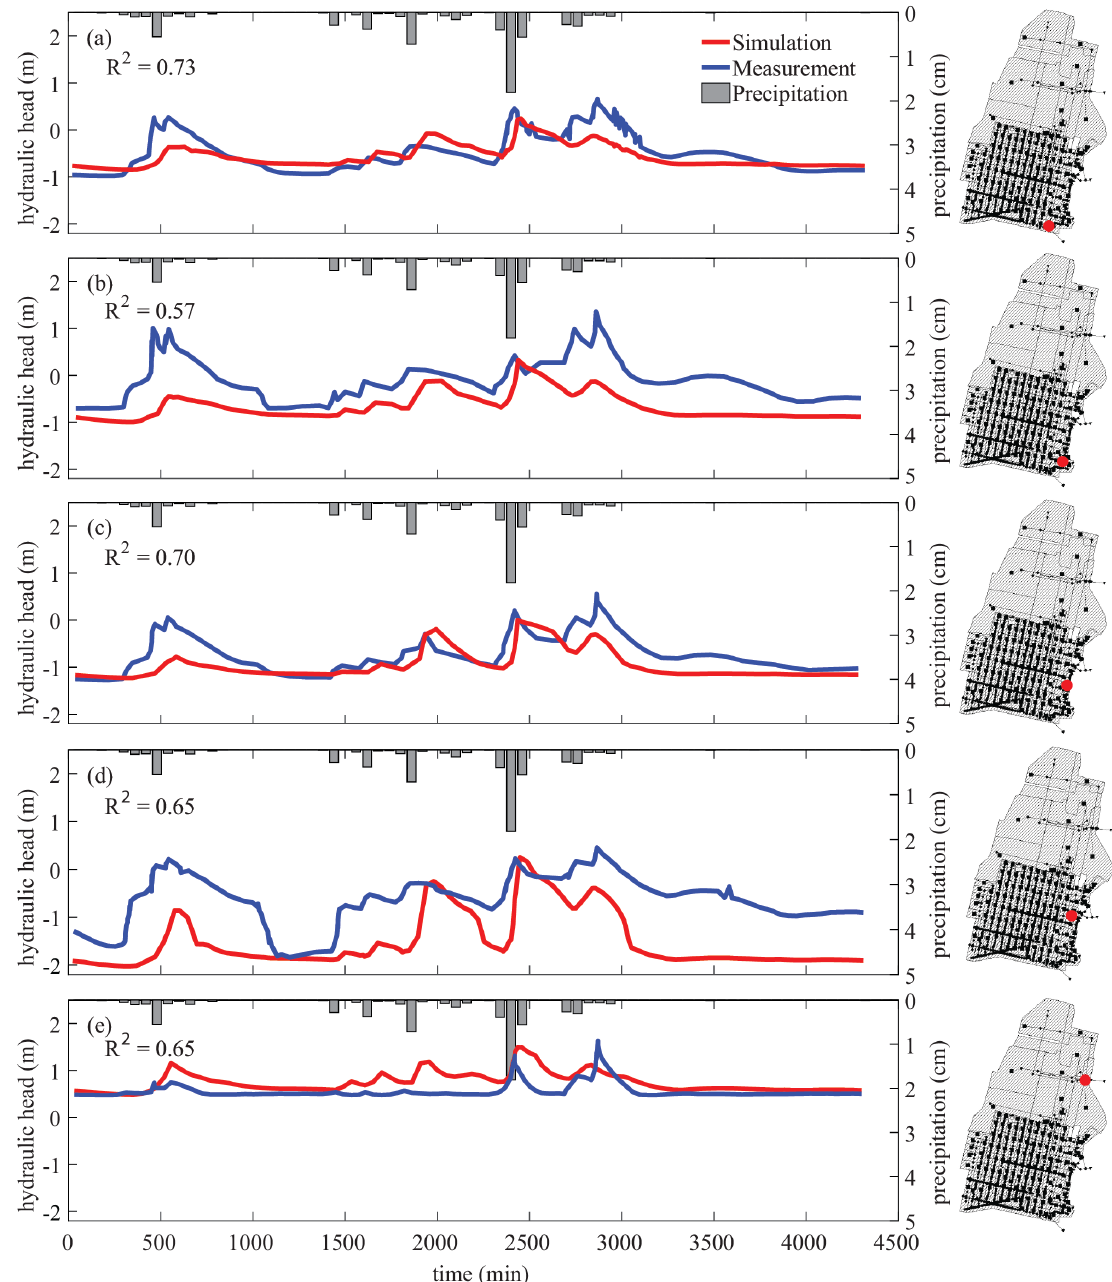
Figure 6. Validation of the sewer model in WWCs. The diagrams report the hydraulic head of the water within the pipe (solid lines) and precipitation depth. The measurements were carried out at five regulators indicated in the insets, from 17 May 2011 to 20 May 2011 [65]. ( a – e ) show the comparison of simulations with the measurements for, correspondingly, regulators 1 through